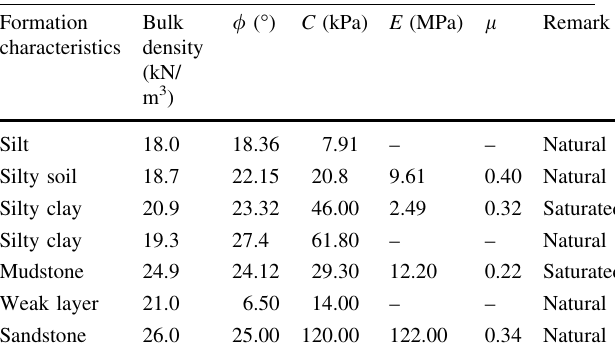
Fig. 12 Cloud diagram of slope displacement vector of section P-1